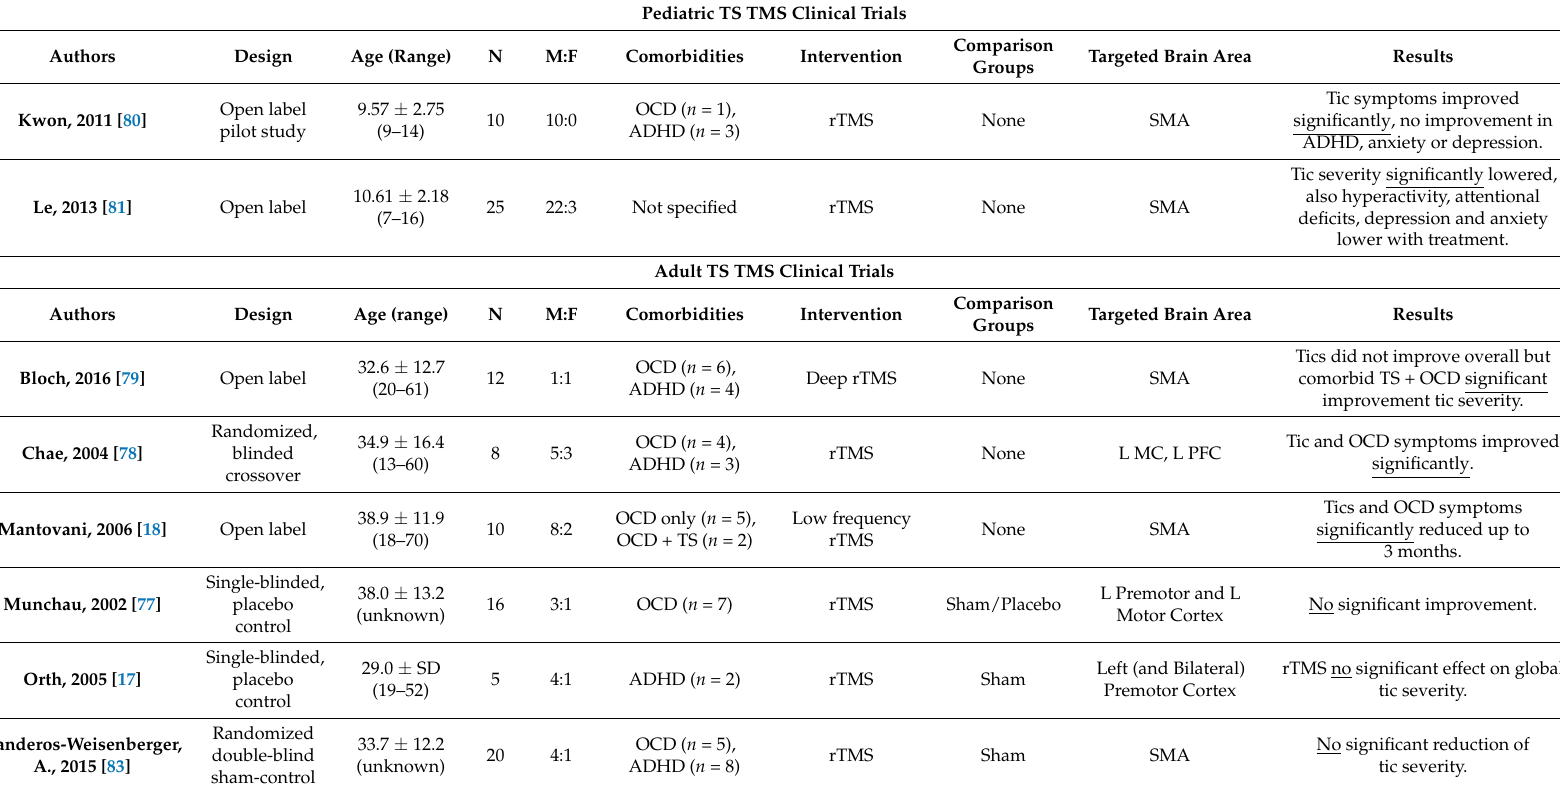
Table 1. Clinical Trials of Transcranial Magnetic in Children and Adults with Tourette